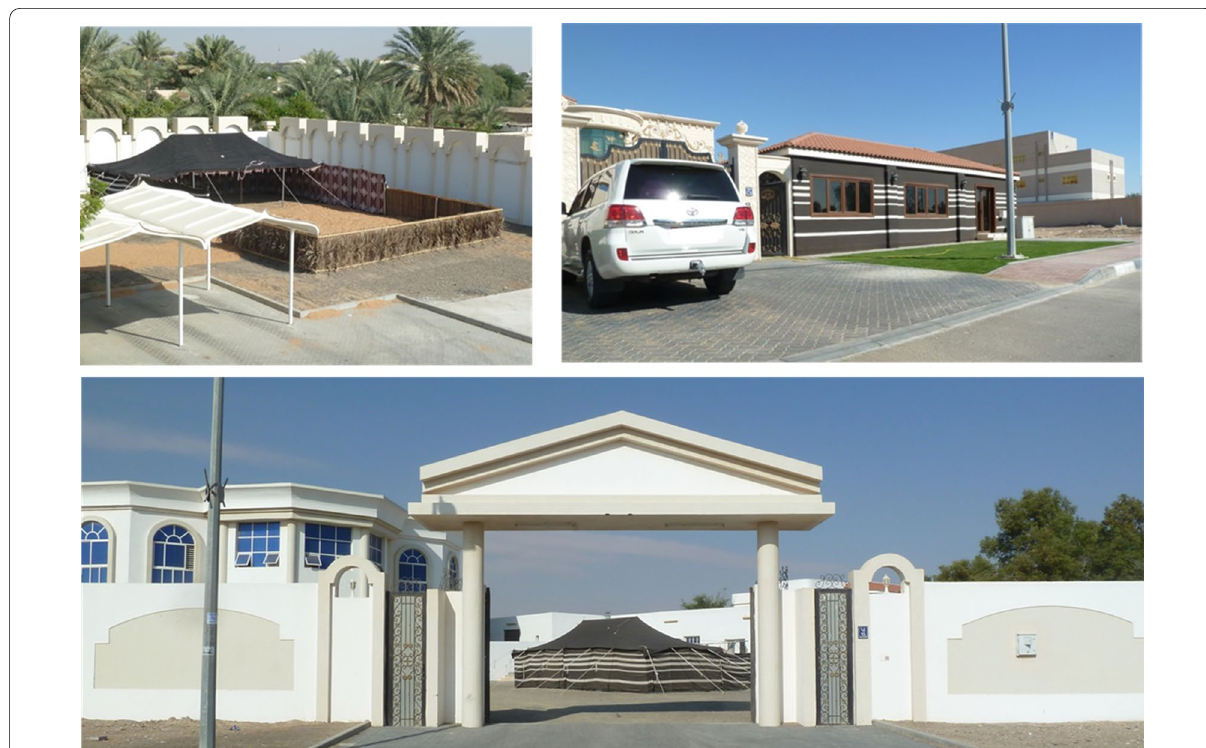
Fig. 6 Spatial accretions in contemporary villas. Left: An ad-hoc tent Majlis , reminiscent of bait al shaar , inside the perimeter compound of an Emirati villa. Right: A perimeter-built neo-majlish facing the road. Note the permanent structure of Majlis is cladded with fabric in distinctive black and white stripes. Note the majlis can be entered directly from the on street parking area. Bottom: Perimeter enclosed villa compound with core villa on left and the ad-hoc tent Majlis and service blocks on the right. Photos: Authors collection 2008–16 Al